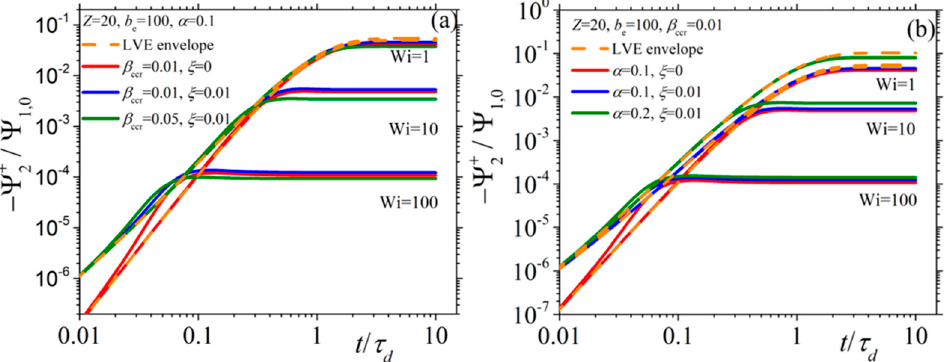
Figure 4. Same as with Figure 2 but for the second normal stress coefficient when ( a ) keeping α constant, and ( b ) keeping β ccr constant.